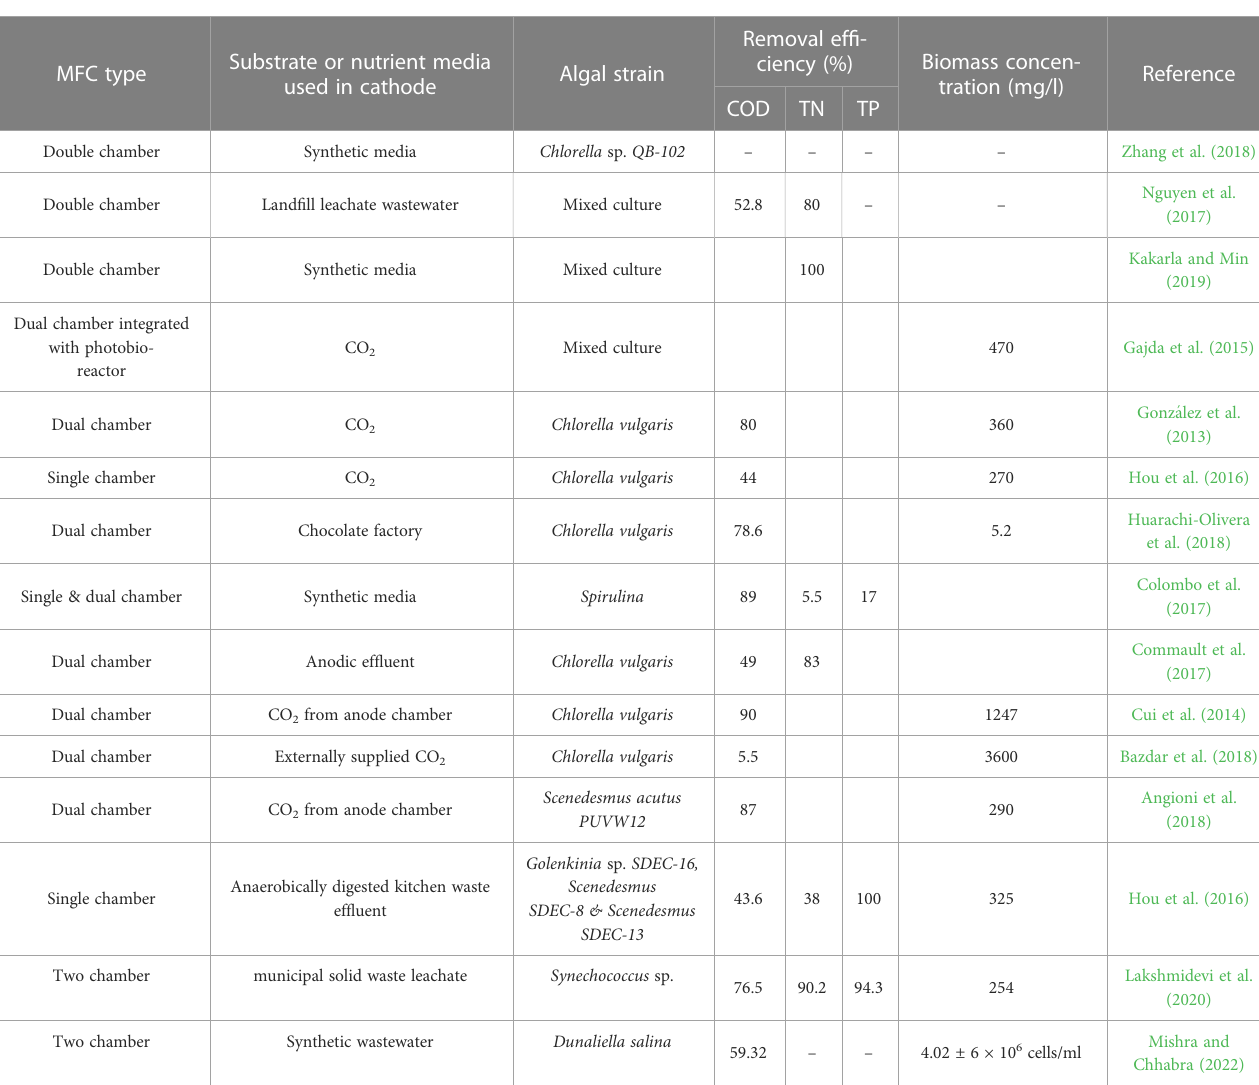
TABLE 5 COD removal and algal biomass generation in algae assisted